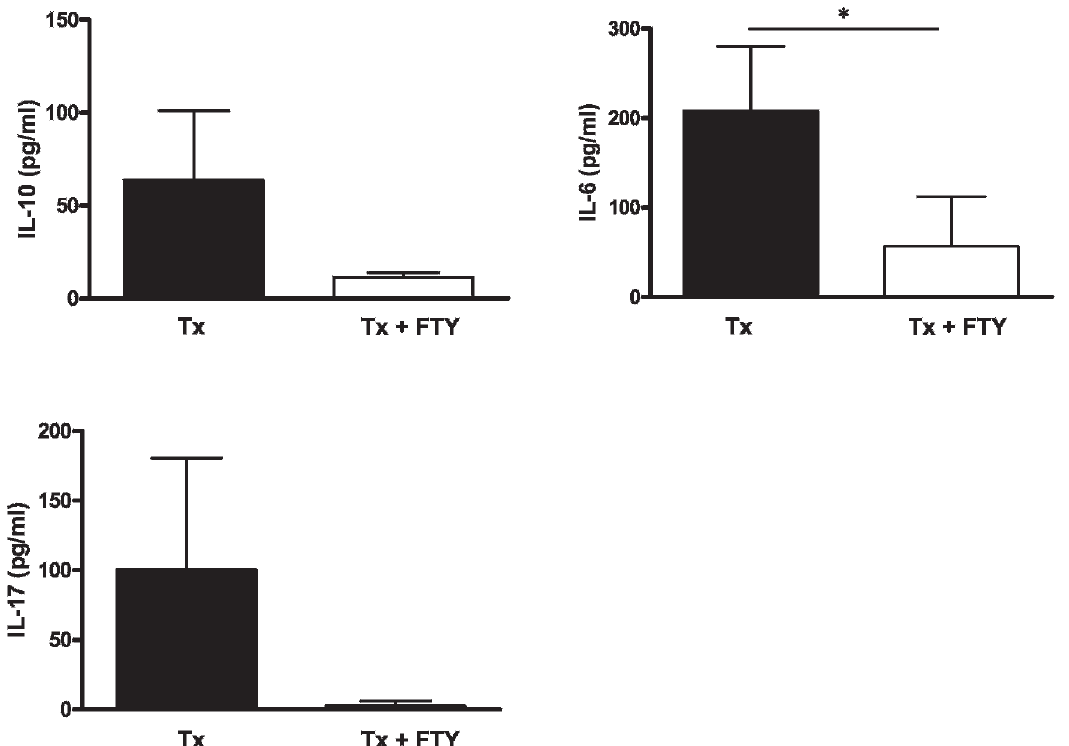
Figure 4 - FTY720 decreases the cytokine production by splenocytes. Analysis of the IL-10, IL-6 and IL-17 secretion levels by the splenocytes. The spleen cells from the Tx non-treated and Tx + FTY720-treated mice were harvested at day 5 post-skin transplantation and stimulated in vitro with anti-CD3. The supernatants were collected 72 h later, and the IL-10, IL-6, and IL-17 levels were determined by multiplex ELISA. The results are expressed as the means ¡ SD (* p ,